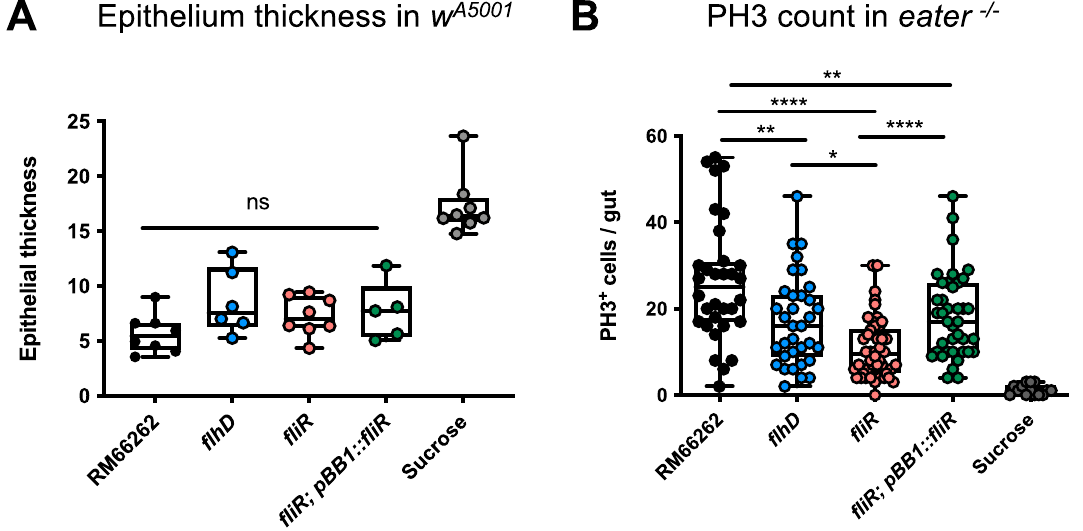
Figure 3. In comparison to flhD , fliR mutant bacteria trigger a lessened compensatory proliferation of Drosophila intestinal stem cells. ( A ) Epithelium thickness measured 3 h post-infection at 25 °C on w A5001 midguts stained with phalloidin (actin). The thickness was measured using the FIJI software, each dot represents the mean of 10 different measurements along the anterior midgut (R2 region). ( B ) Number of mitoses measured using a PH3 staining in whole midguts of eater −/− mutant flies at 25 °C 24 h post-infection. Flies were orally infected with bacteria in the RM66262 background using OD 600nm = 10. IPTG (0.5 mM) was added in the infection solution containing the fliR rescue strain. Each graph represents three independent experiments. Statistical tests were performed using one-way